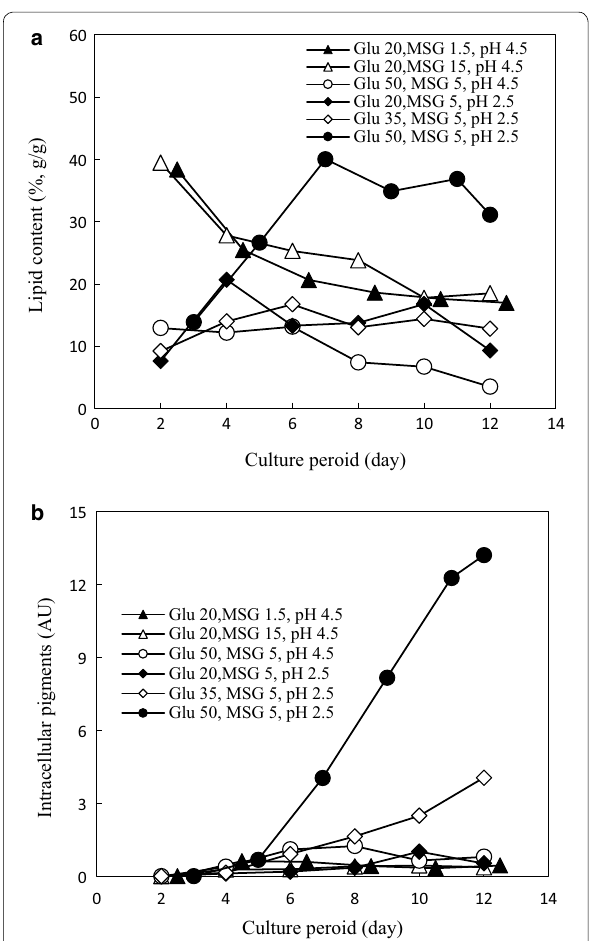
Fig. 1 Effect of cultivation medium on microbial physiology. a Lipid content, defined as the lipid weight per 100 g lipid-free DCW; b intra- cellular Monascus pigments, normalized to biomass concentration of 10 g lipid-free DCW per liter. The data are average of triplicates. For clear vision, no error bar was